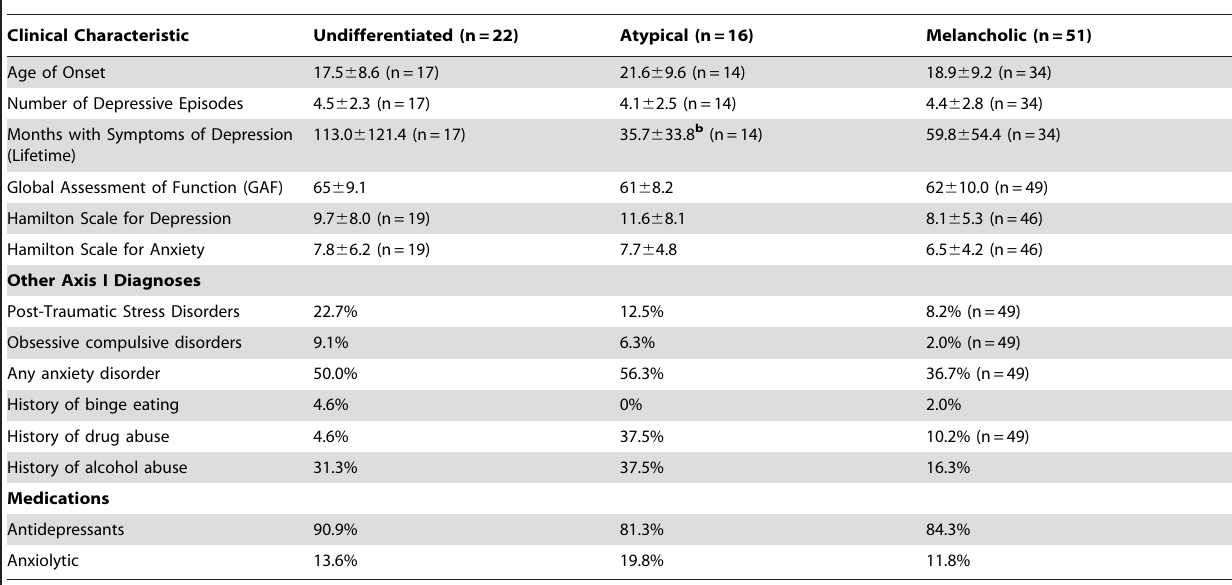
Table 2. Clinical characteristics of depressive subtypes of women with unipolar MDD.